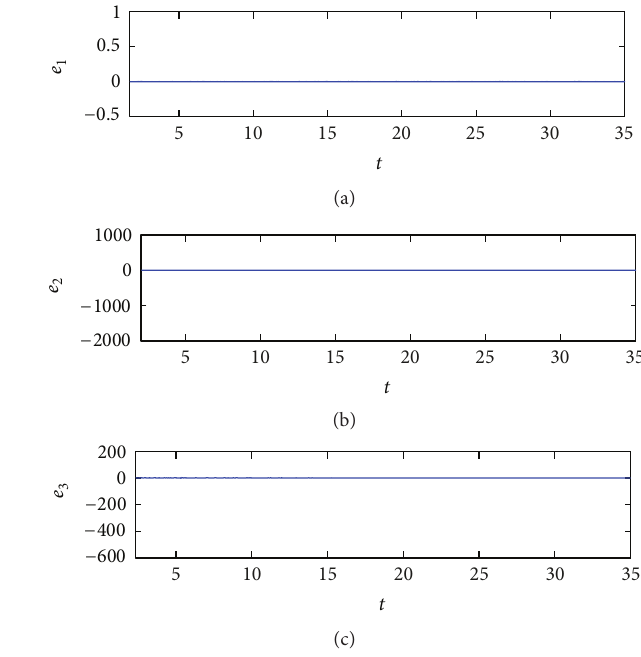
Figure 1: The trajectories of the error system without control input in Example 1.